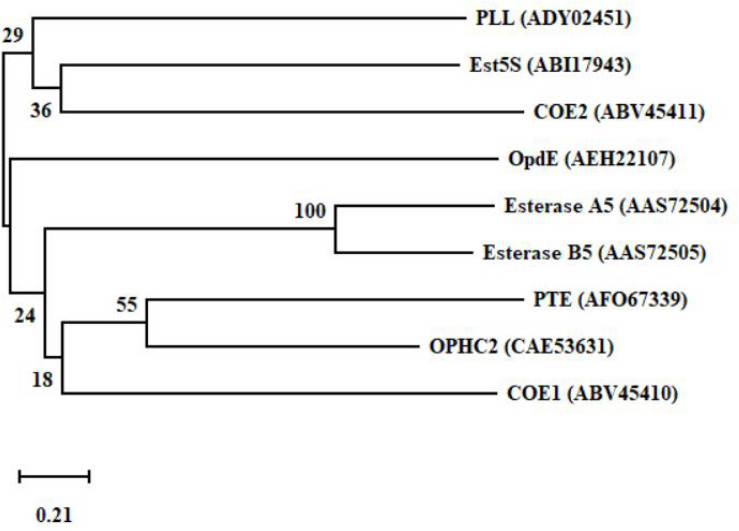
A phylogenetic tree of the key functional enzymes involved in the degradation of organophosphate pesticides. PTE was isolated from Pseudomonas monteilii (Horne et al., 2002). OPHC2 was isolated from Pseudomonas pseudoalcaligenes (Gotthard et al., 2013). PLL was isolated from Vulcanisaeta moutnovskia (Kallnik et al., 2014). Est5S was isolated from cow rumen bacteria (Kambiranda et al., 2009). OpdE was isolated from Enterobacter sp. (Chino-Flores et al., 2012). COE1 was isolated from Bemisia tabaci (Alon et al., 2008). COE2 was isolated from Bemisia tabaci (Alon et al., 2008). Esterase A5 was isolated from Culex pipiens (Buss and Callaghan, 2004). Esterase B5 was isolated from Culex pipiens (Buss and Callaghan, 2004).